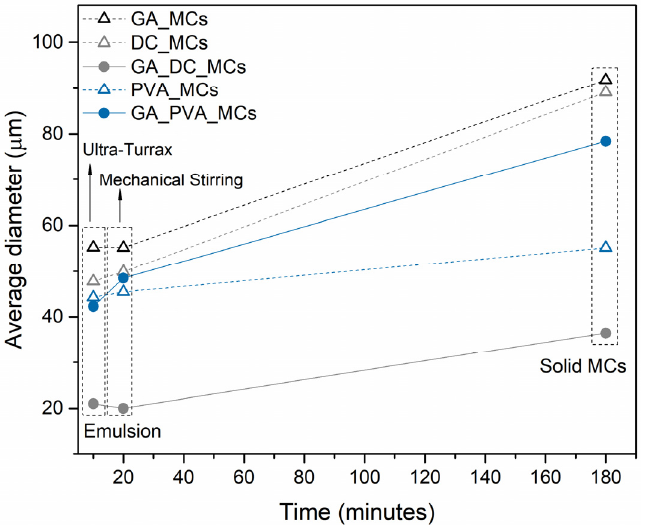
Figure 5. Oil emulsion droplets average diameter at the end of the emulsion preparation (10 min), after 10 min under mechanical agitation (20 min), and of the final MCs (180 min).